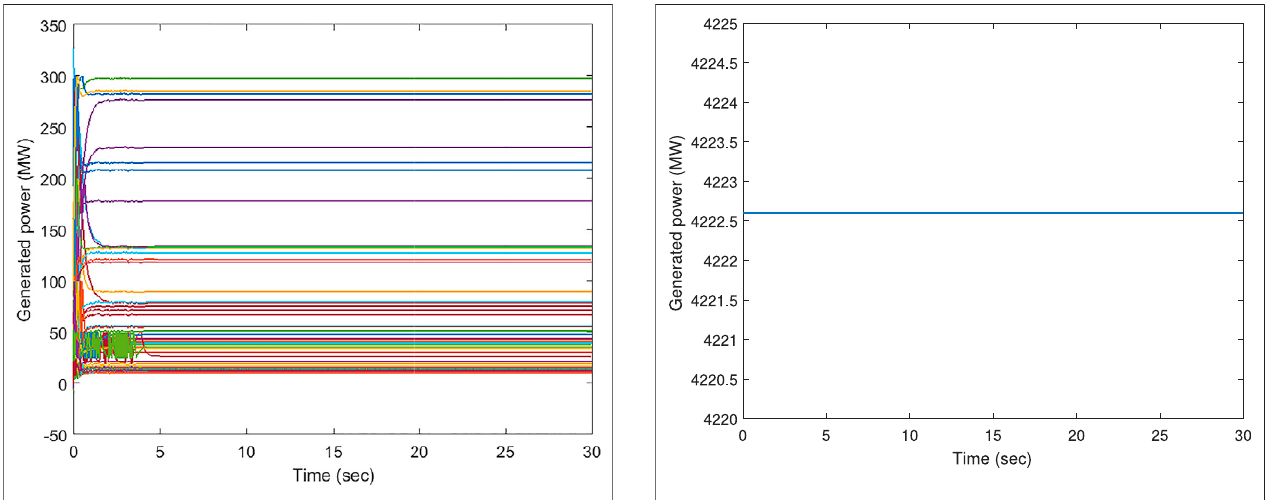
FIGURE 11 | Generation obtained using the proposed approach for IEEE-118 bus system.